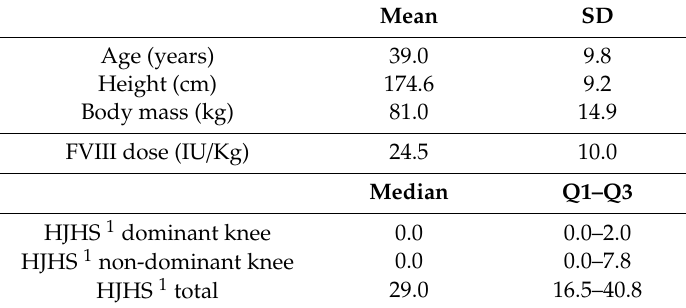
Table 1. Demographic and descriptive